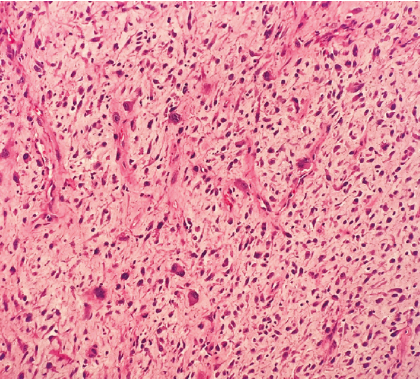
Figure 4: This histopathology illustrates multiple pleomorphic cells (tumor cells) from the partial resection of the left intimal